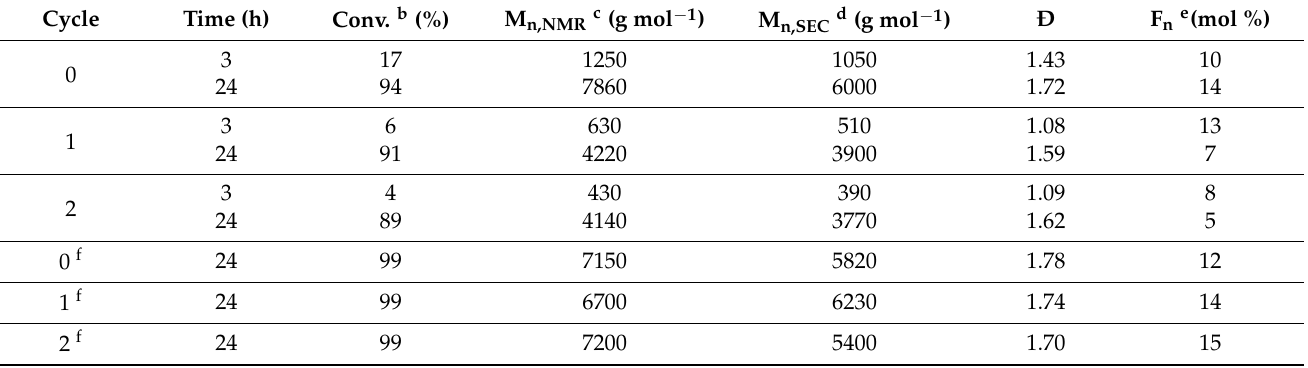
Table 3. Catalyst recycling in bulk ROP of ε -caprolactone with BnOH/HPCP initiating system at 150 ◦ C a